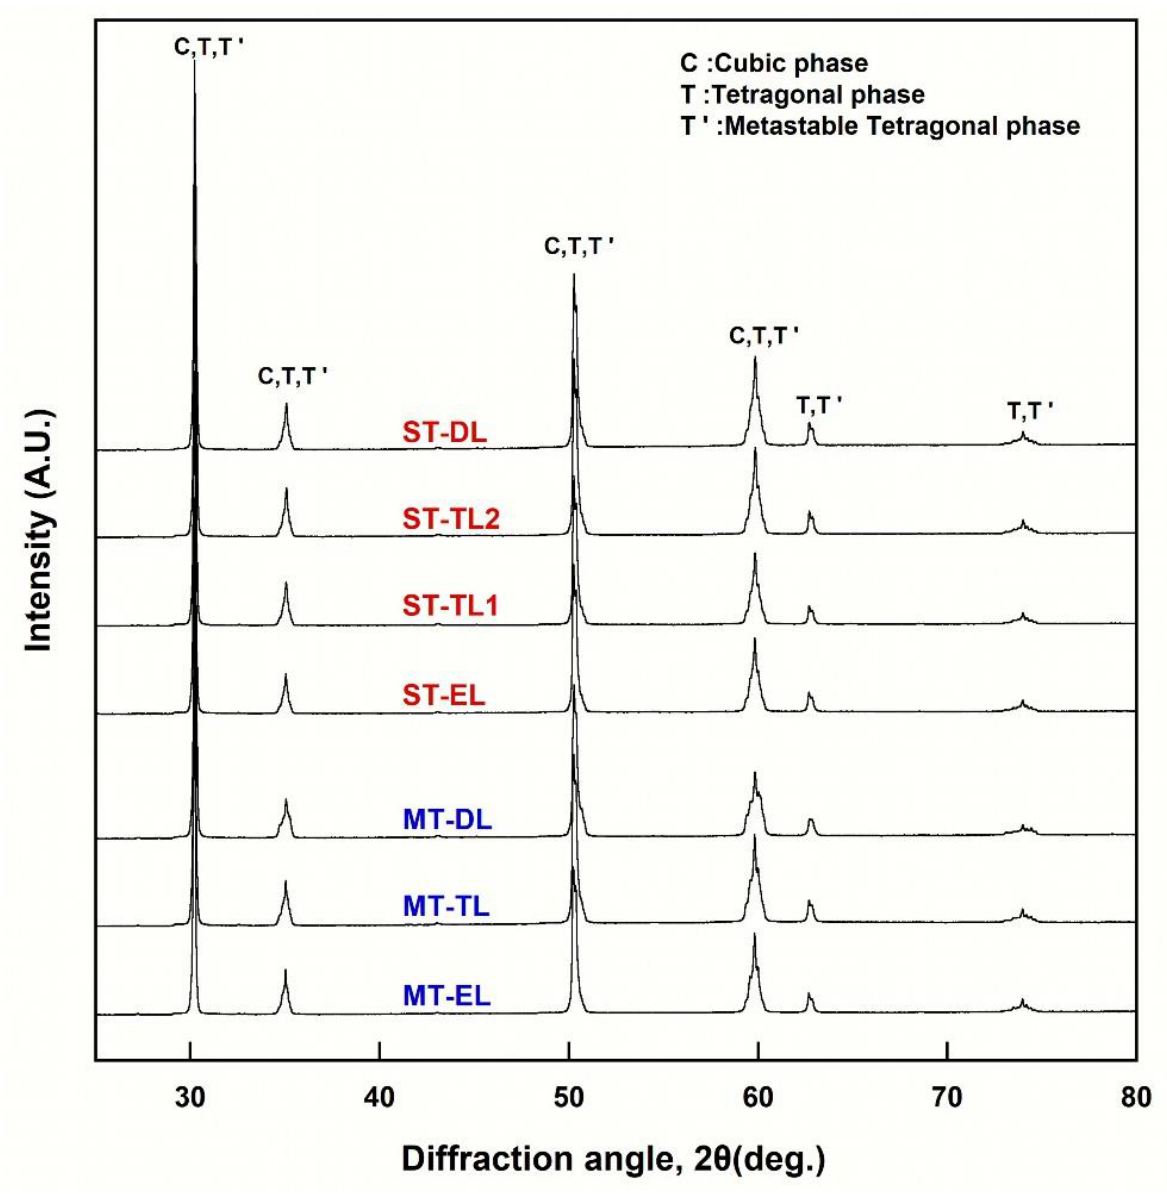
Figure 5. XRD patterns for each layer of sintered zirconia (ST: Katana STML; MT: e.max MT Multi).